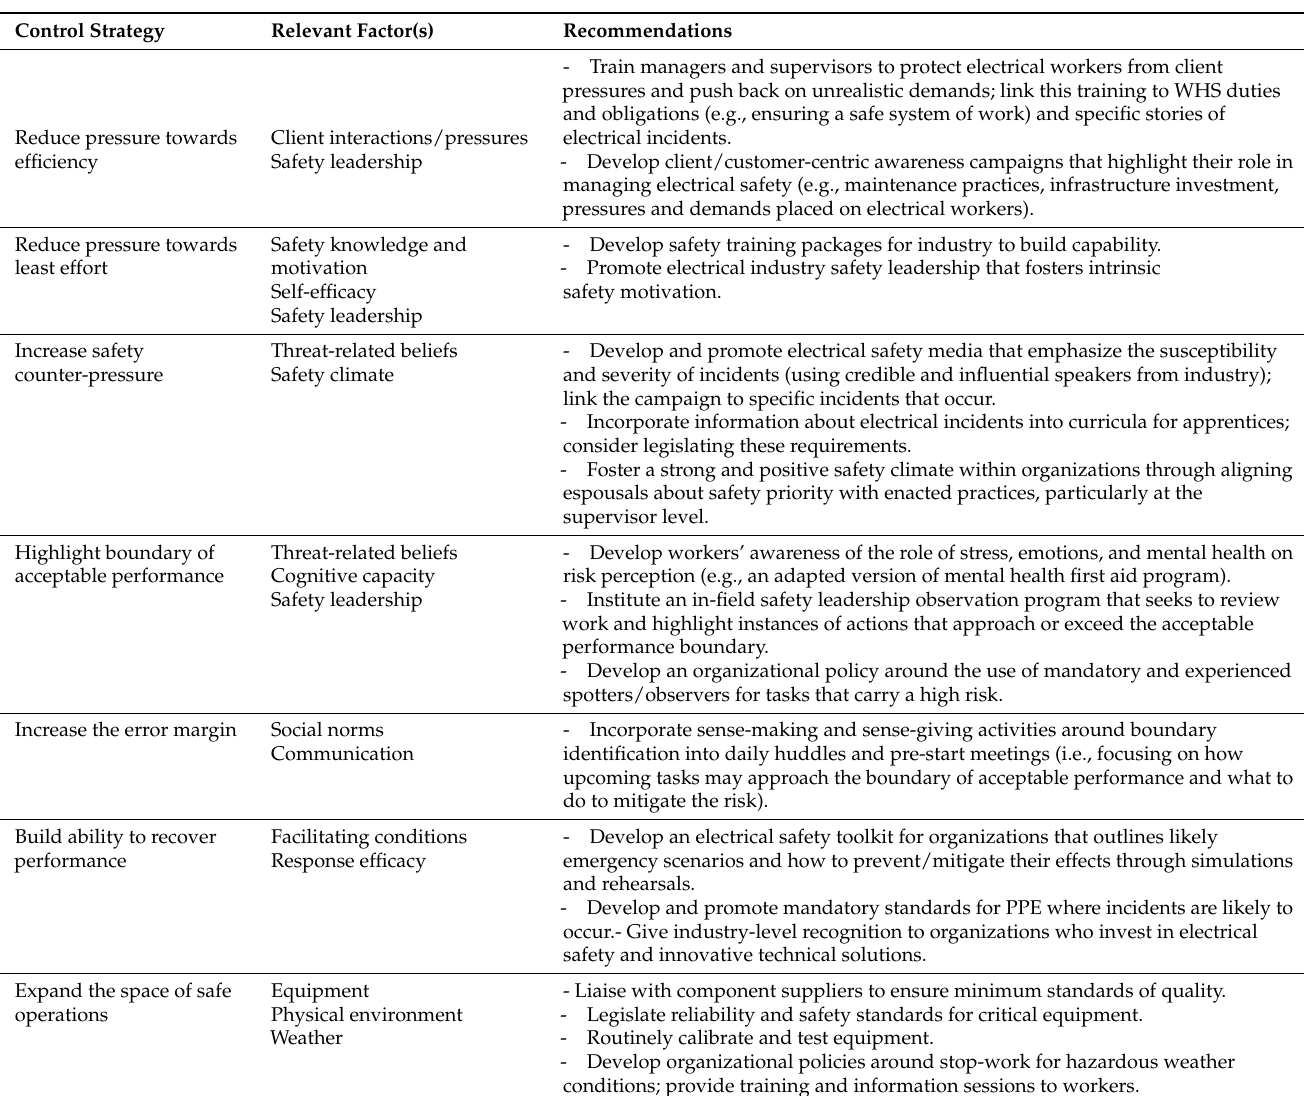
Table 2. Summary of practical recommendations to guide arc flash